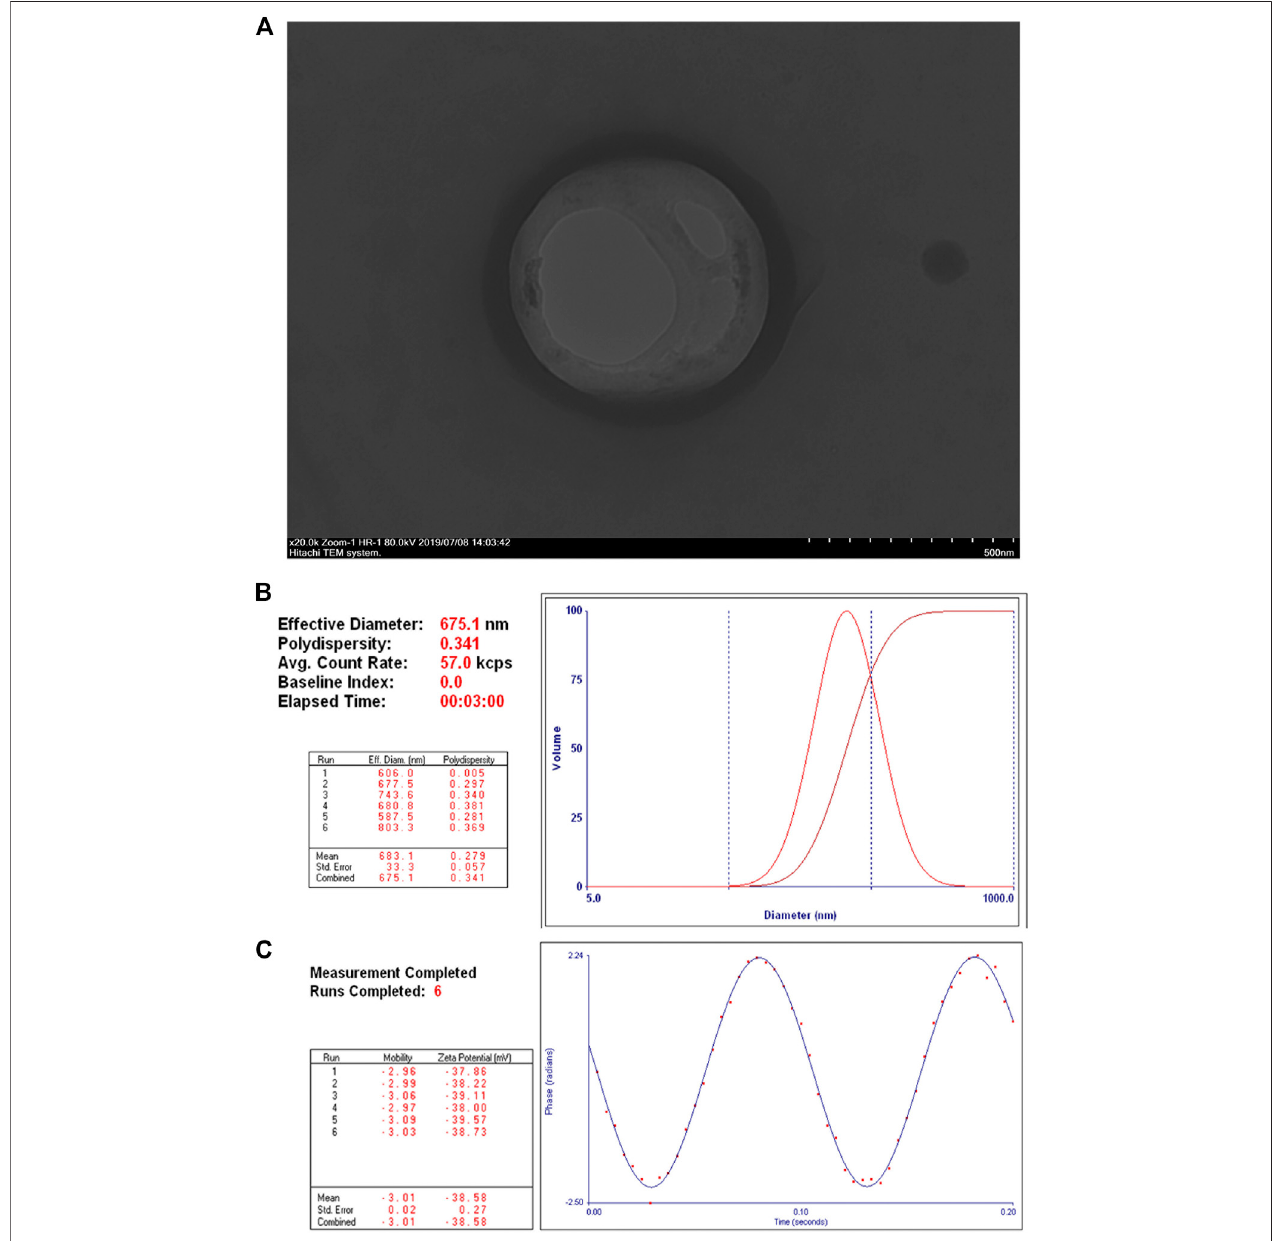
FIGURE 1 | Structure and characterization of NET-1 siRNA nanoparticles. (A) Transmission electron microscopy image showed a quasi-spherical morphology of NET-1 siRNA nanoparticles with a diameter of about 600 nm. Original magni fi cation, × 20,000. Scale bar, 500 nm; (B) the DLS results showed a mean particle size of NET-1 siRNA nanoparticles to be 675.1 ± 33.3 nm with a 0.341 polydispersity value; (C) the Zeta PALS BI-90 Plus analyzer indicated a surface zeta potential of NET-1 siRNA nanoparticles to be – 38.58 ± 0.27